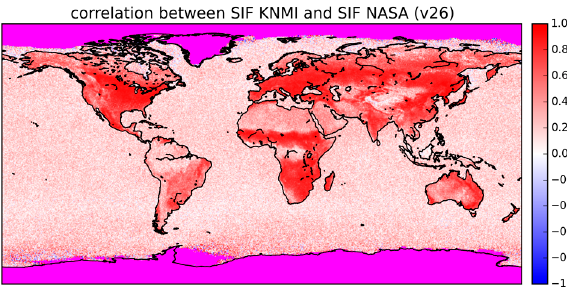
Figure 9. Global map of correlations between the GOME-2A SiF time series presented in this paper (SiF KNMI) and SiF NASA (v26). The correlation for a particular grid box is calculated from 102 months at maximum. When less than three months in one of the two time series report valid SiF averages, a correlation is not calculated (purple).